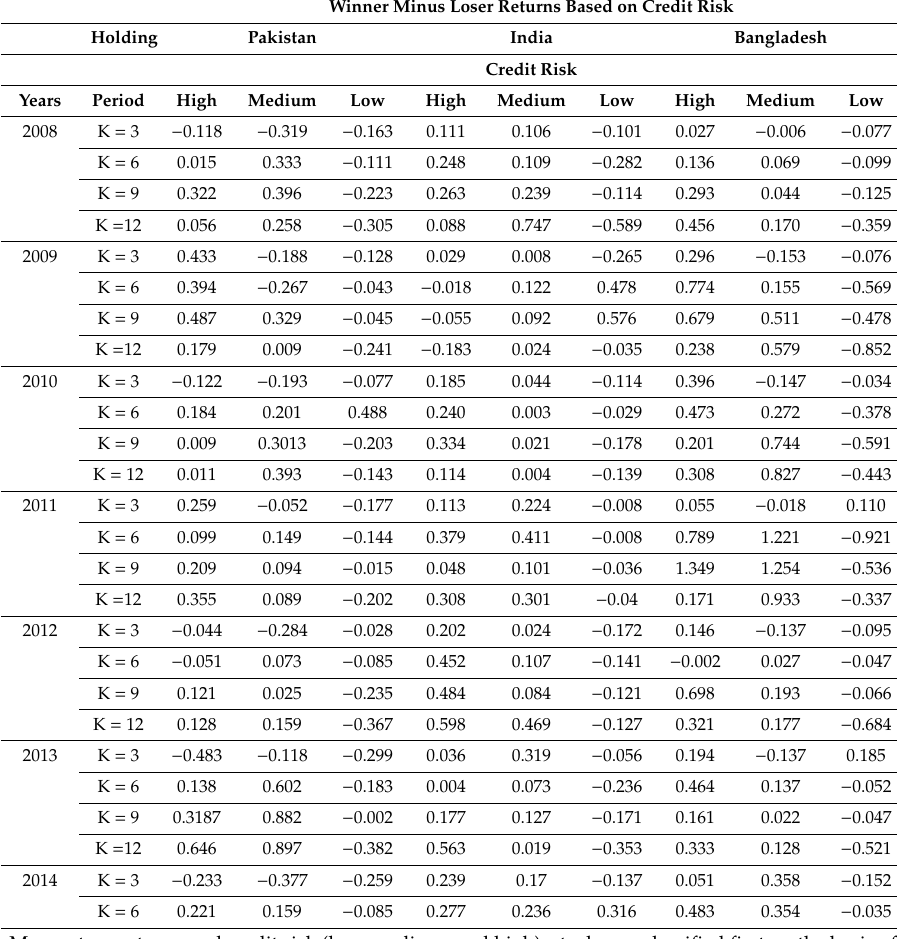
Table 3. Momentum returns by credit risk.